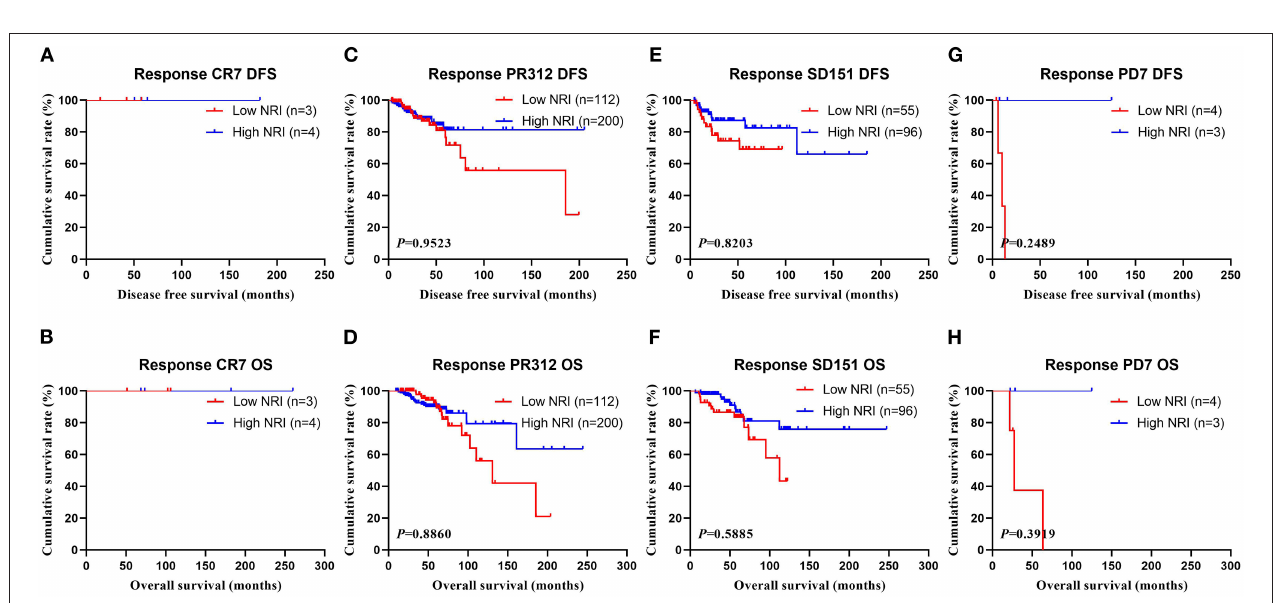
FIGURE 5 | DFS and OS for the NRI of breast cancer patients in Miller and Payne grade (MPG) in NACT group. (A) Kaplan-Meier analysis of DFS of patients with MPG 1, (B) Kaplan-Meier analysis of OS of patients with MPG 1, (C) Kaplan-Meier analysis of DFS of patients with MPG 2, (D) Kaplan-Meier analysis of OS of patients with MPG 2, (E) Kaplan-Meier analysis of DFS of patients with MPG 3, (F) Kaplan-Meier analysis of OS of patients with MPG 3, (G) Kaplan-Meier analysis of DFS of patients with MPG 4, (H) Kaplan-Meier analysis of OS of patients with MPG 4, (I) Kaplan-Meier analysis of DFS of patients with MPG 5, (J) Kaplan-Meier analysis of OS of patients with MPG 5.